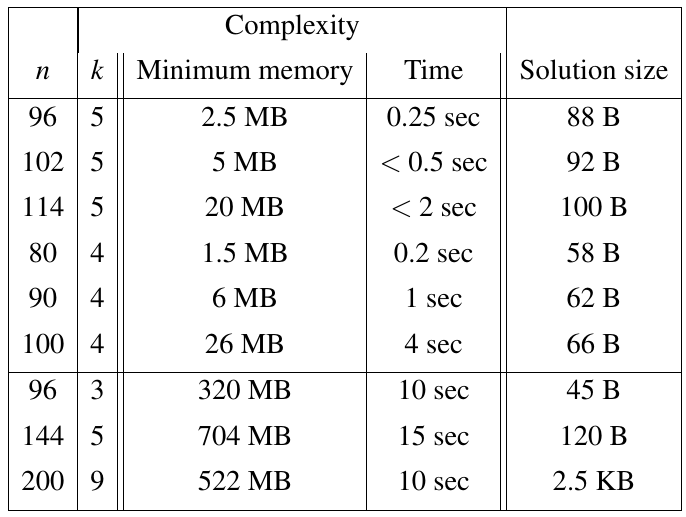
Table 2. Performance of our Equihash solver on 2.1 GHz machine with a sin- gle thread. Minimum memory is the optimized amount of memory given by Proposition 2; our implementation takes about 4 times as